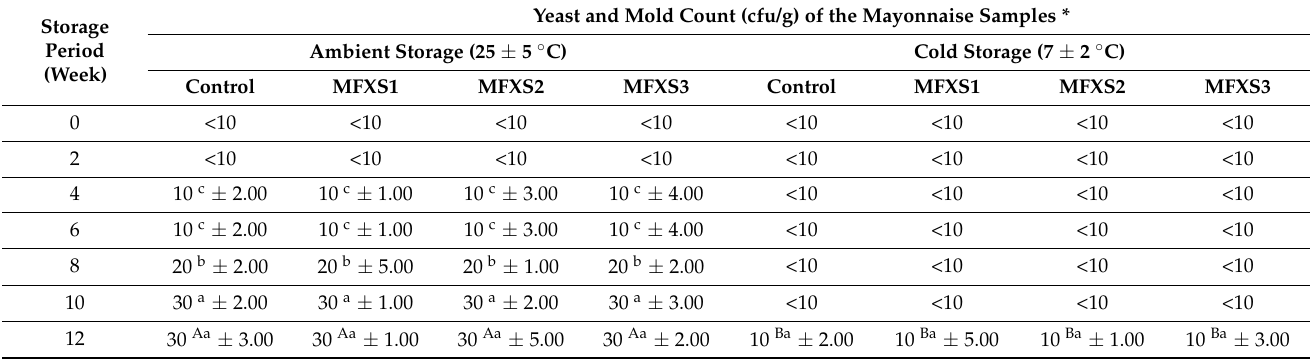
Table 4. Yeast and mold counts (cfu/g) of mayonnaise samples during ambient and cold